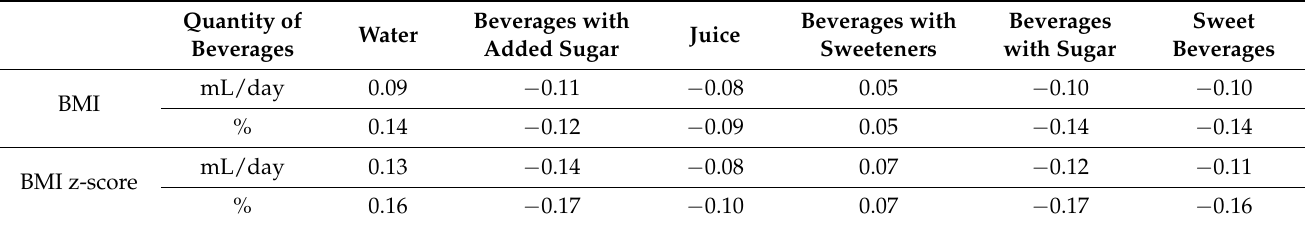
Table 5. Relationship between BMI and BMI z-scores with the absolute amounts and per- centages of different beverages consumed after active and passive intervention (Spearman’s correlation